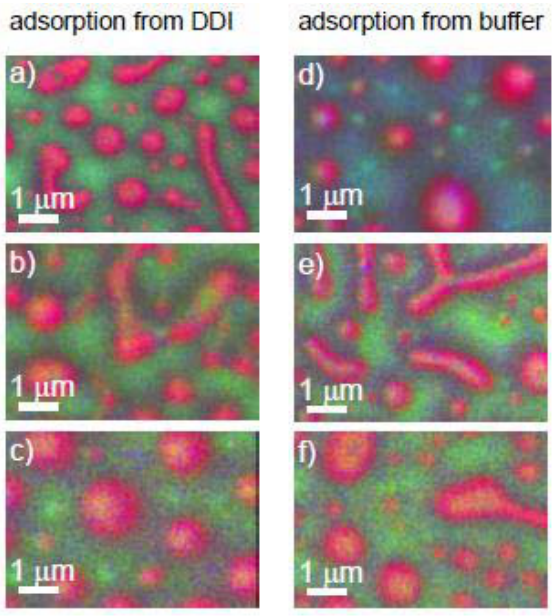
Figure 7. X-PEEM color coded composite maps of 40:60 PS/PLA films (0.7 wt % loading) annealed 1 h at 70 °C with HSA adsorption from water: (a) 0.05 mg/mL, (b) 0.01 mg/mL, (c) 0.005 mg/mL; HSA adsorption from buffer: (d) 0.05 mg/mL, (e) 0.01 mg/mL, (f) 0.005 mg/mL. PS = red, PLA = green, HSA = blue [32] (reproduced with permission of the publisher).